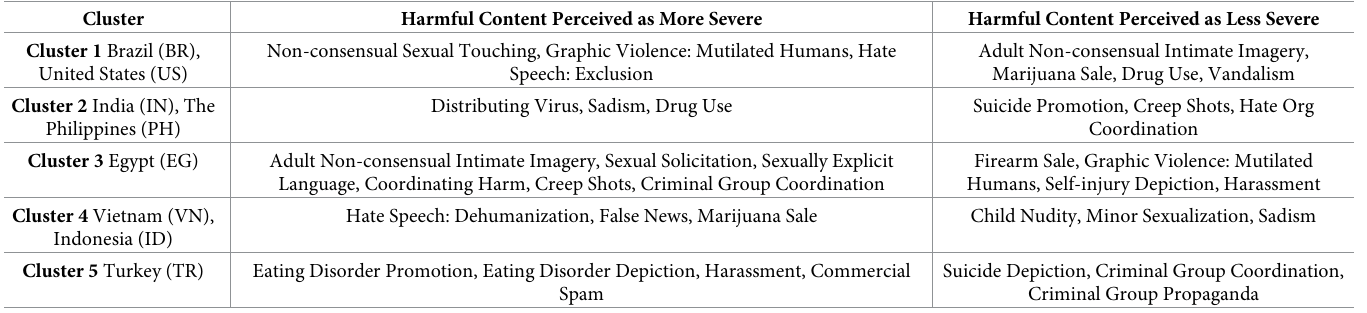
Suicide Depiction, Criminal Group Coordination, Criminal Group